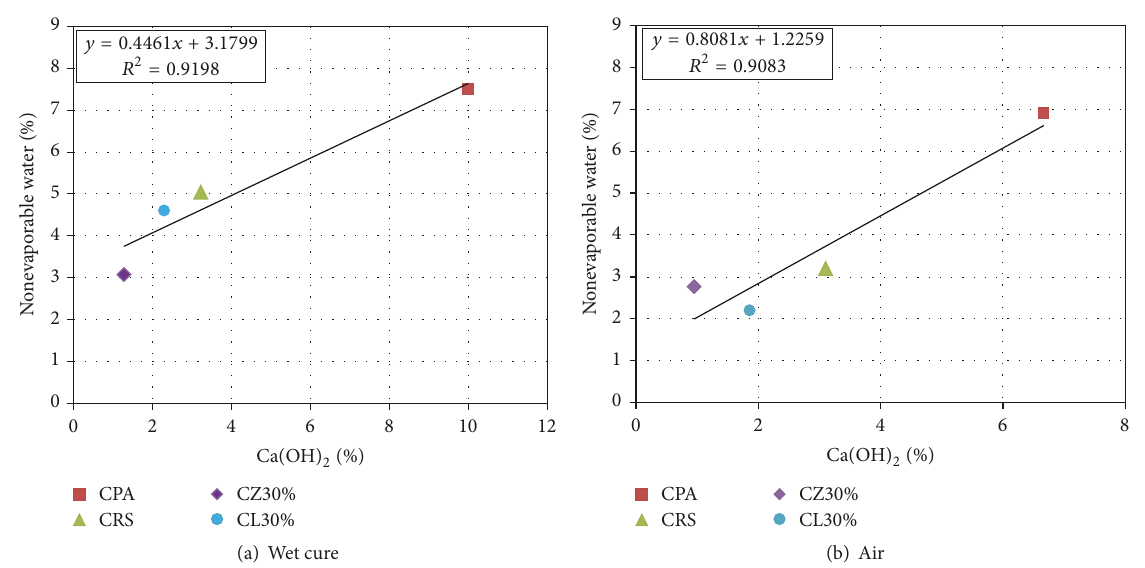
Figure 17: Portlandite content as a function of nonevaporable